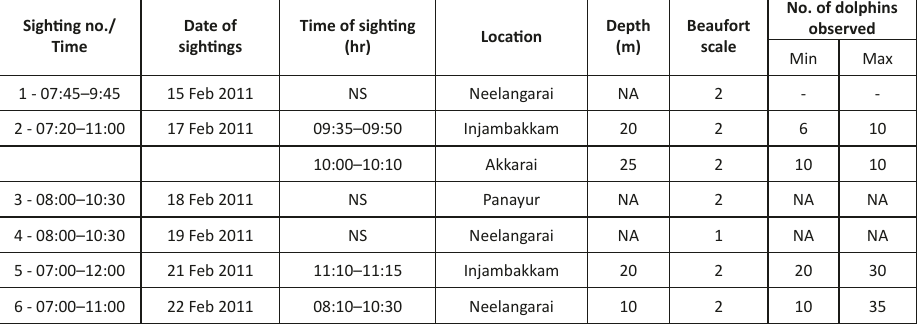
NA - not applicable; NS - no sightings